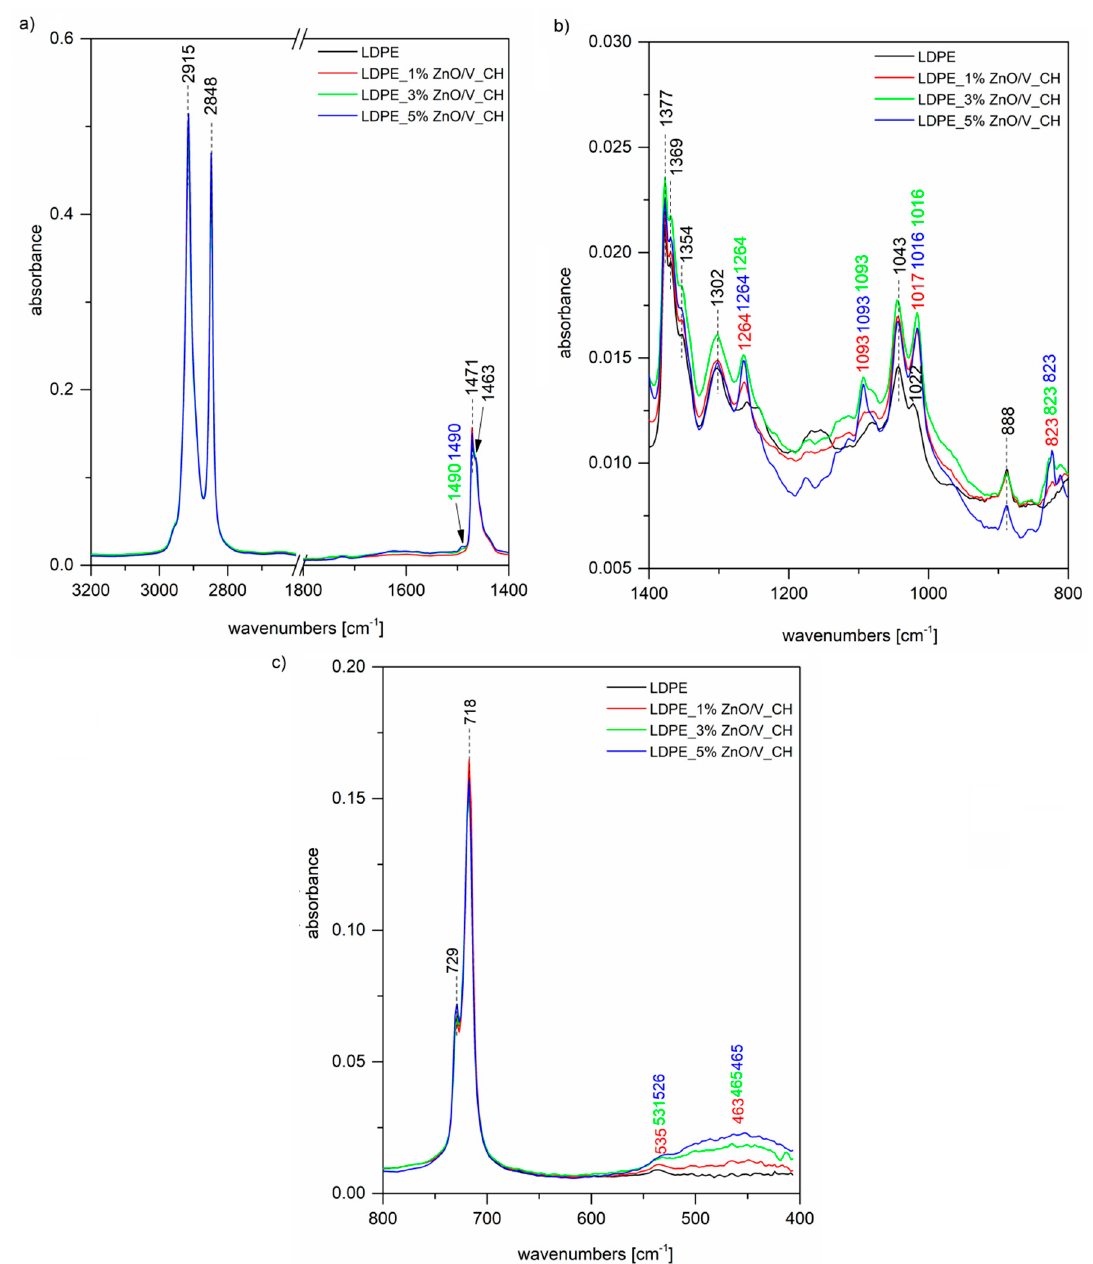
Figure 5. FTIR spectra of the original LDPE and LDPE_ZnO/V_CH nanocomposite plates at regions